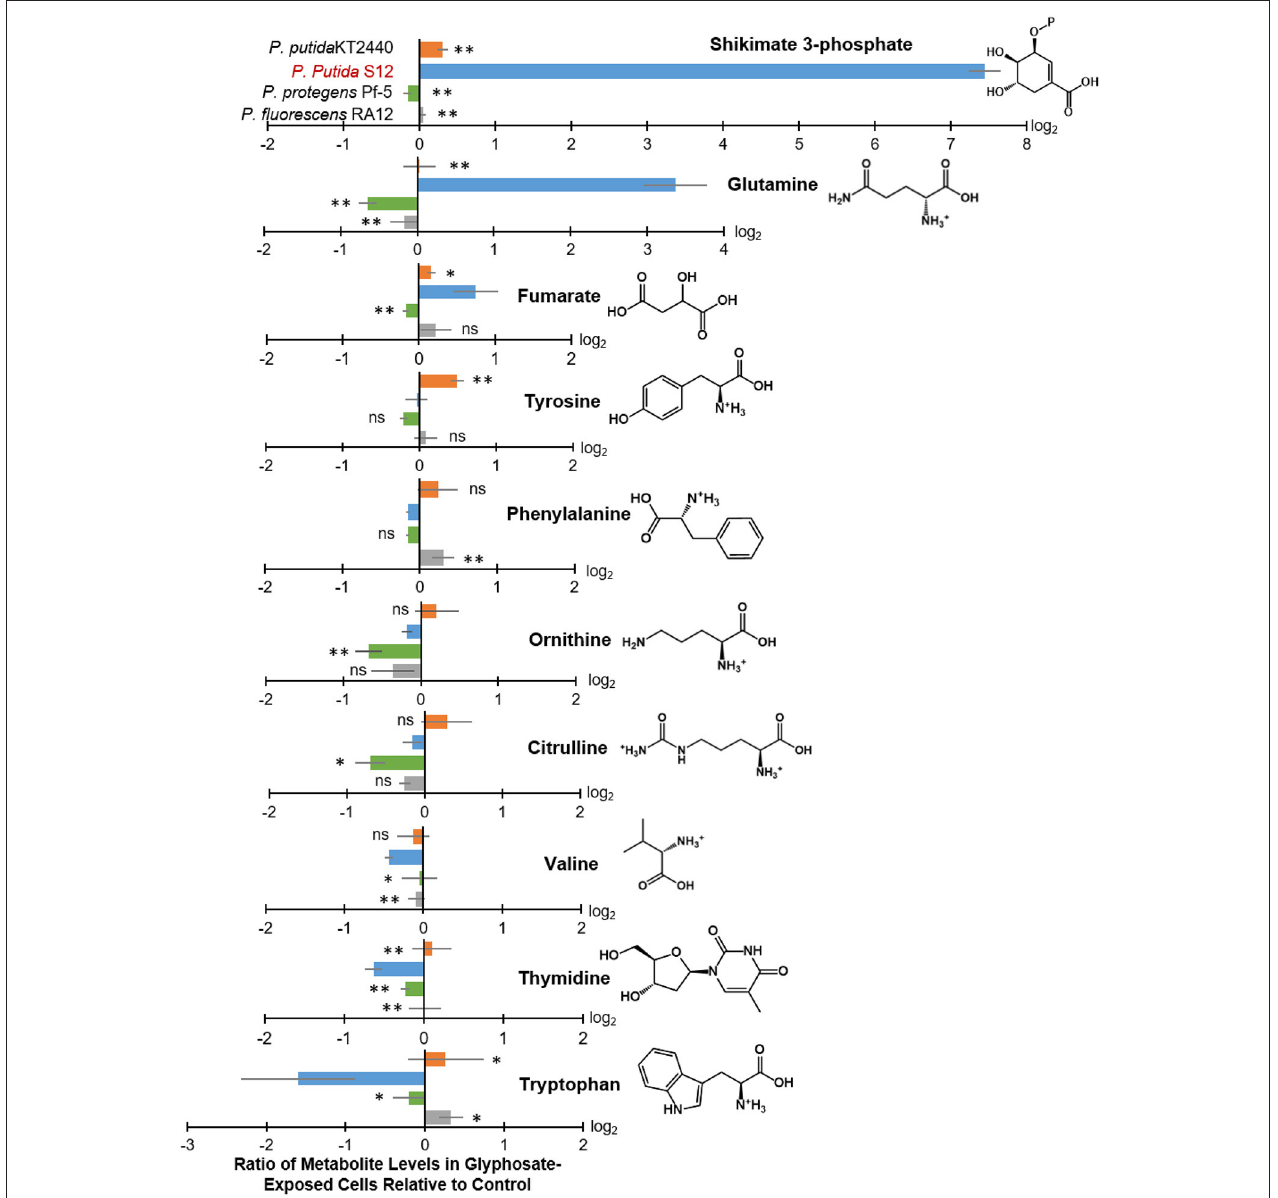
FIGURE 4 | Intracellular levels of selected metabolites in glyphosate-exposed cells relative to control. Extracted from the cellular metabolome shown in Figure 3 are log 2 -tranformed ratios of metabolite levels in glyphosate-exposed cells (at 0.5mM) relative to control with statistically-significant differences across the different Pseudomonas species: P . putida KT2440 (orange), P. putida S12 (light blue), P. protegens Pf-5 (green), and P. fluorescens RA12 (gray). Data (average ± standard deviation) were obtained from three independent biological replicates. Two-tailed unpaired t- test analysis comparing the ratios obtained with P. putida S12 (the most sensitive species) to those obtained with each of the other species: p < 0.01 (**), p < 0.05 (*), not statistically significant